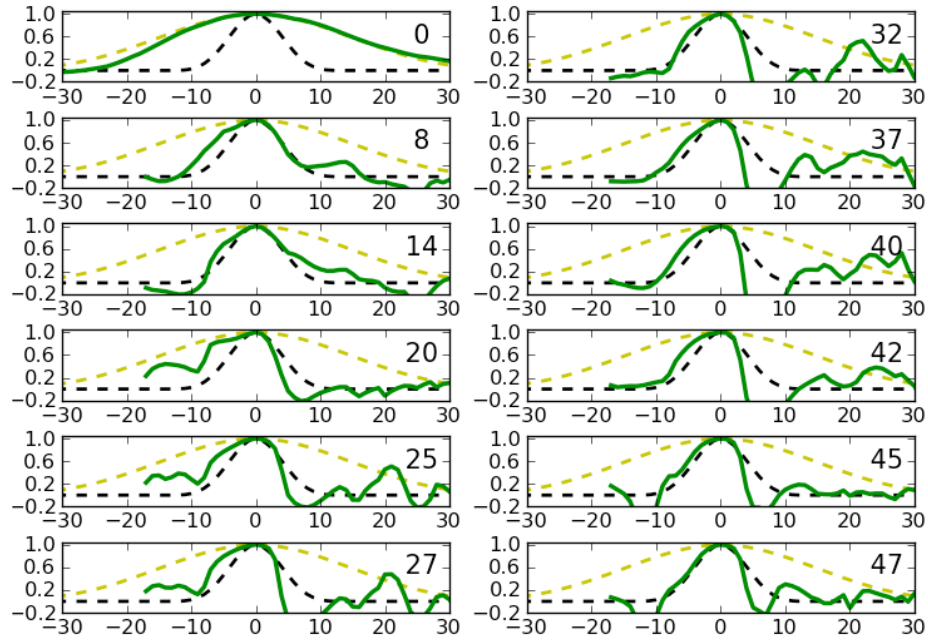
Fig. 6. Evolution of the correlation function at a particular grid point (marked x in area W1 in Fig. 4) for the experiment with l = c = 20. Each panel is for a different update cycle. The numbers inside each panel show the update cycle.